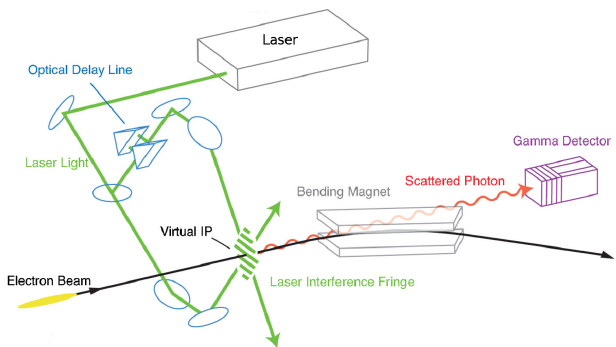
FIG. 6. Measured modulation during the α y scan to resolve the vertical emittance at the IP and the β (cid:1) y value using the Shintake monitor in 30 degree